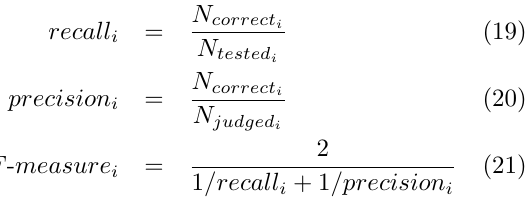
Table 4. Confusion matrix of 4-class classi(cid:12)cation using